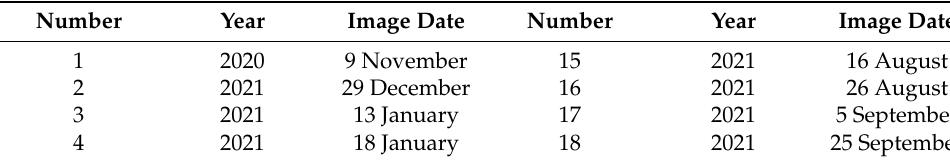
Table 2. Dates of selected Sentinel